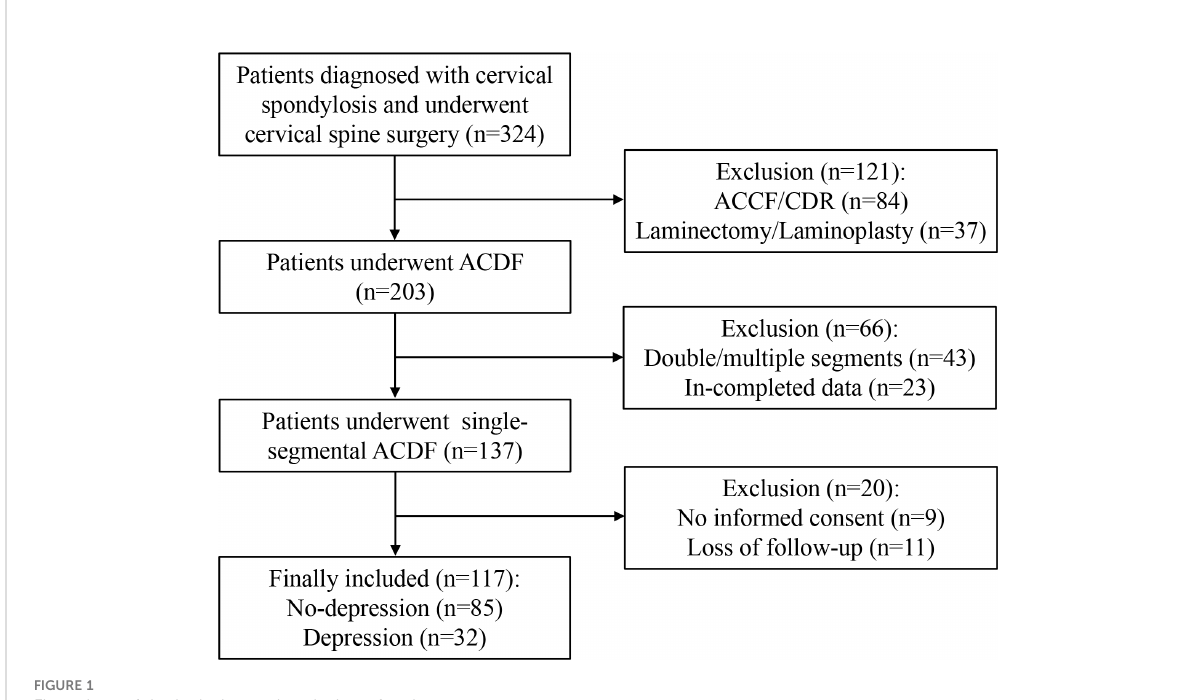
FIGURE 1 Flow chart of the inclusion and exclusion of patients.